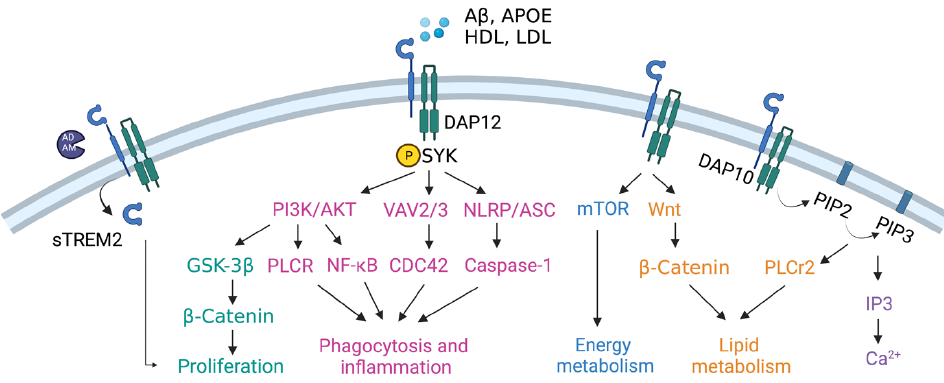
Figure 2. The cascade signaling pathways are mediated by TREM2 in microglia. sTREM2 can promote microglial proliferation. TREM2 can also promote microglial proliferation by activating the GSK-3 β / β -catenin signal pathway. Meanwhile, TREM2 can promote phagocytosis and inflammatory response through the PI3K/AKT-PLCR, PI3K/AKT-NF- κ B, VAV2/3-CDC42 and NLRP-caspase-1 signal pathways. TREM2 can regulate energy metabolism of microglia through mTOR signal pathway, and lipid metabolism through Wnt- β -catenin and PIP3-PLCr2 signal pathways. TREM2 also can affect calcium homeostasis through regulating the PIP2/3-IP3 signal pathway.